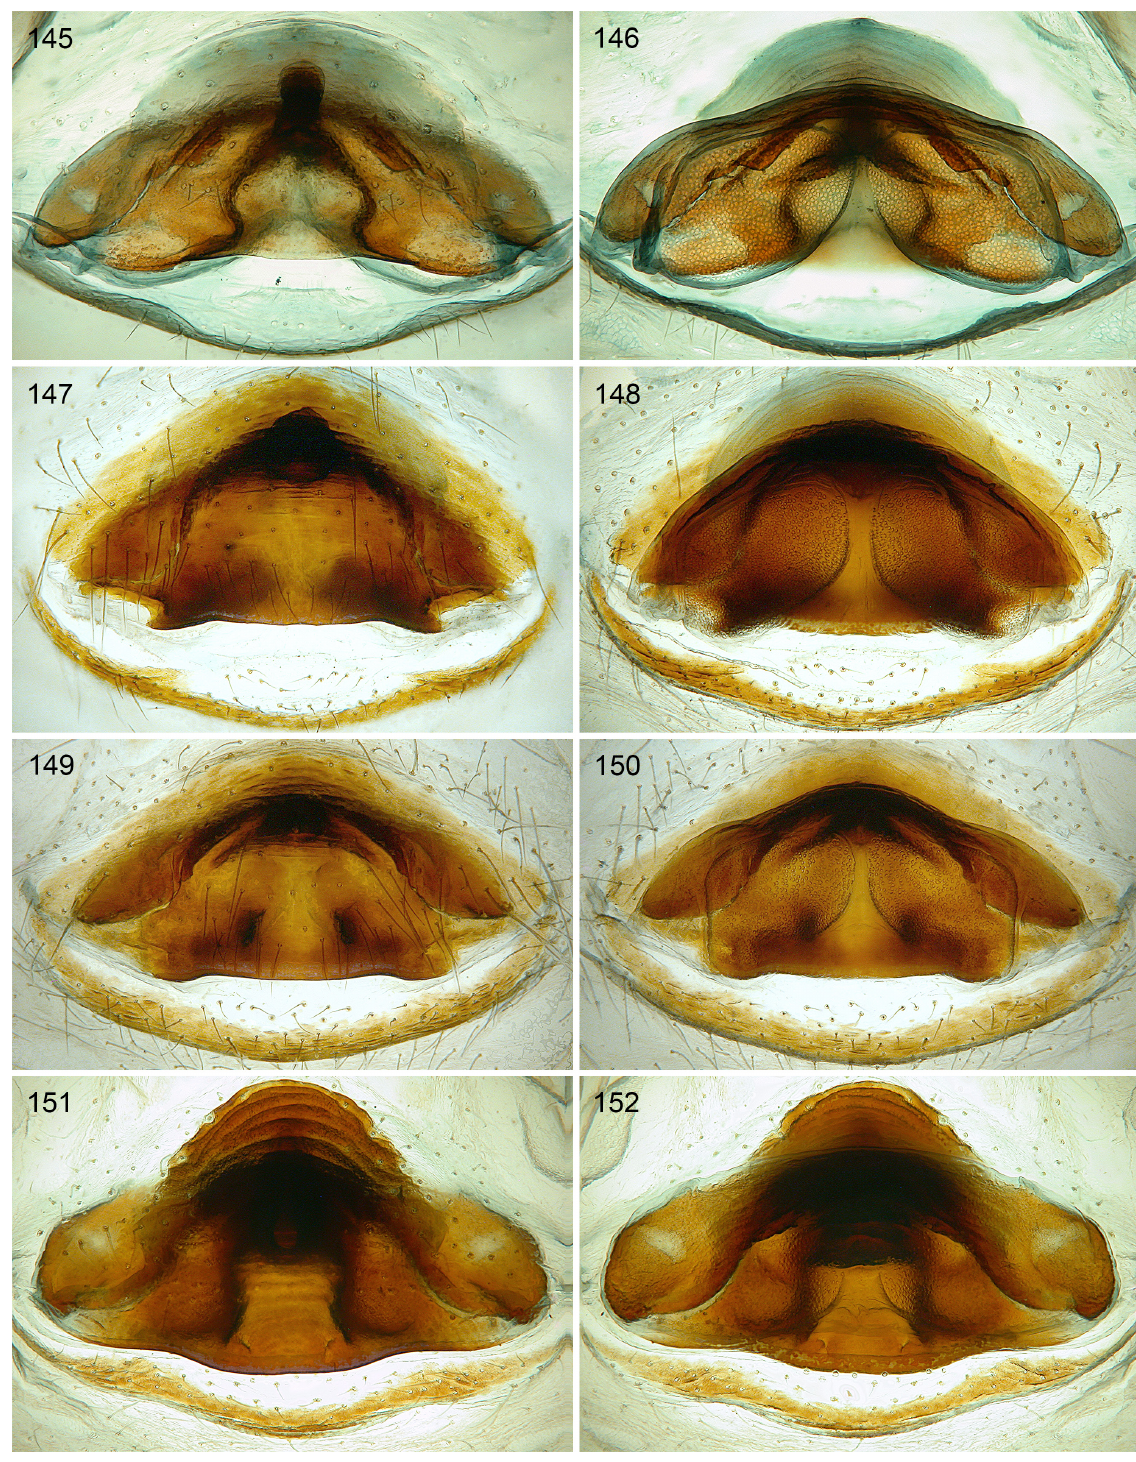
Figs 145–152. Stygopholcus Kratochvíl, 1932; cleared female genitalia, ventral and dorsal views. 145–146 . S. absoloni (Kulczyński, 1914); from Zavala, Bosnia and Herzegovina (MHNG). 147– 148 . S. skotophilus Kratochvíl, 1940; from Pećina u Ivici, Montenegro ((ZFMK Ar 22196)). 149– 150 . S. montenegrinus Kratochvíl, 1940; from Golubinja pećina, Montenegro (CMK). 151–152 . S. photophilus Senglet, 1971; from Choumerion/Pérama, Crete